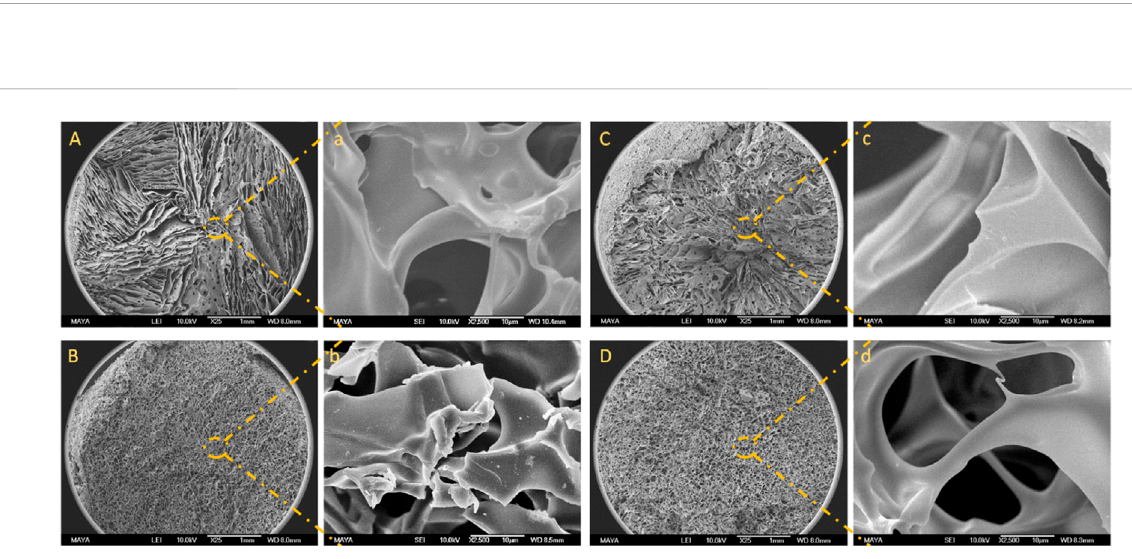
FIGURE 2 SEMimagesofBSA-CGwithBSA(50 mg/ml)andEDC: (A) 37 mg/ml; (B) 46 mg/ml; (C) 56 mg/ml,and (D) 62 mg/ml.Imagesa,b,canddarethe high magni fi cation of images A, B, C and D, respectively. The scale bars are 1 mm and 10 μ m for low- and high-magni fi cation images,